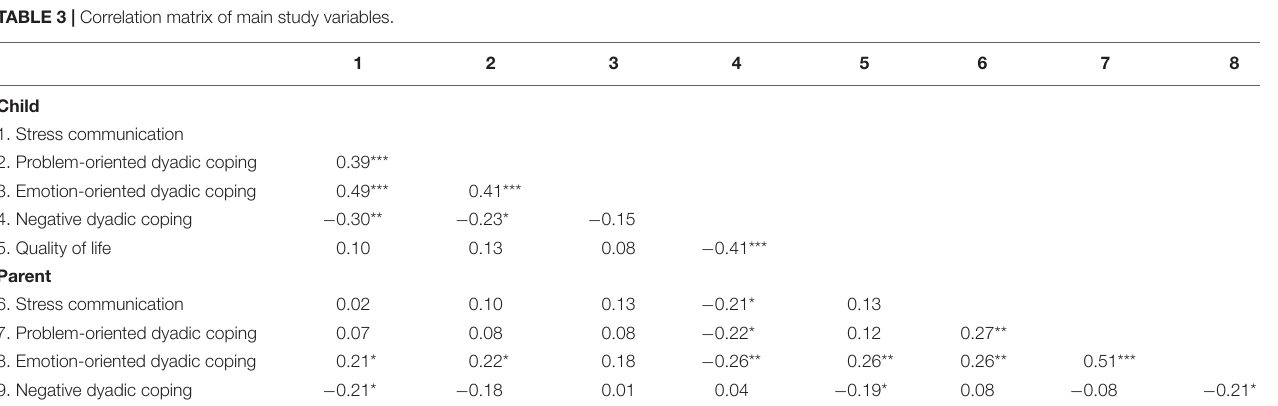
TABLE 3 | Correlation matrix of main study